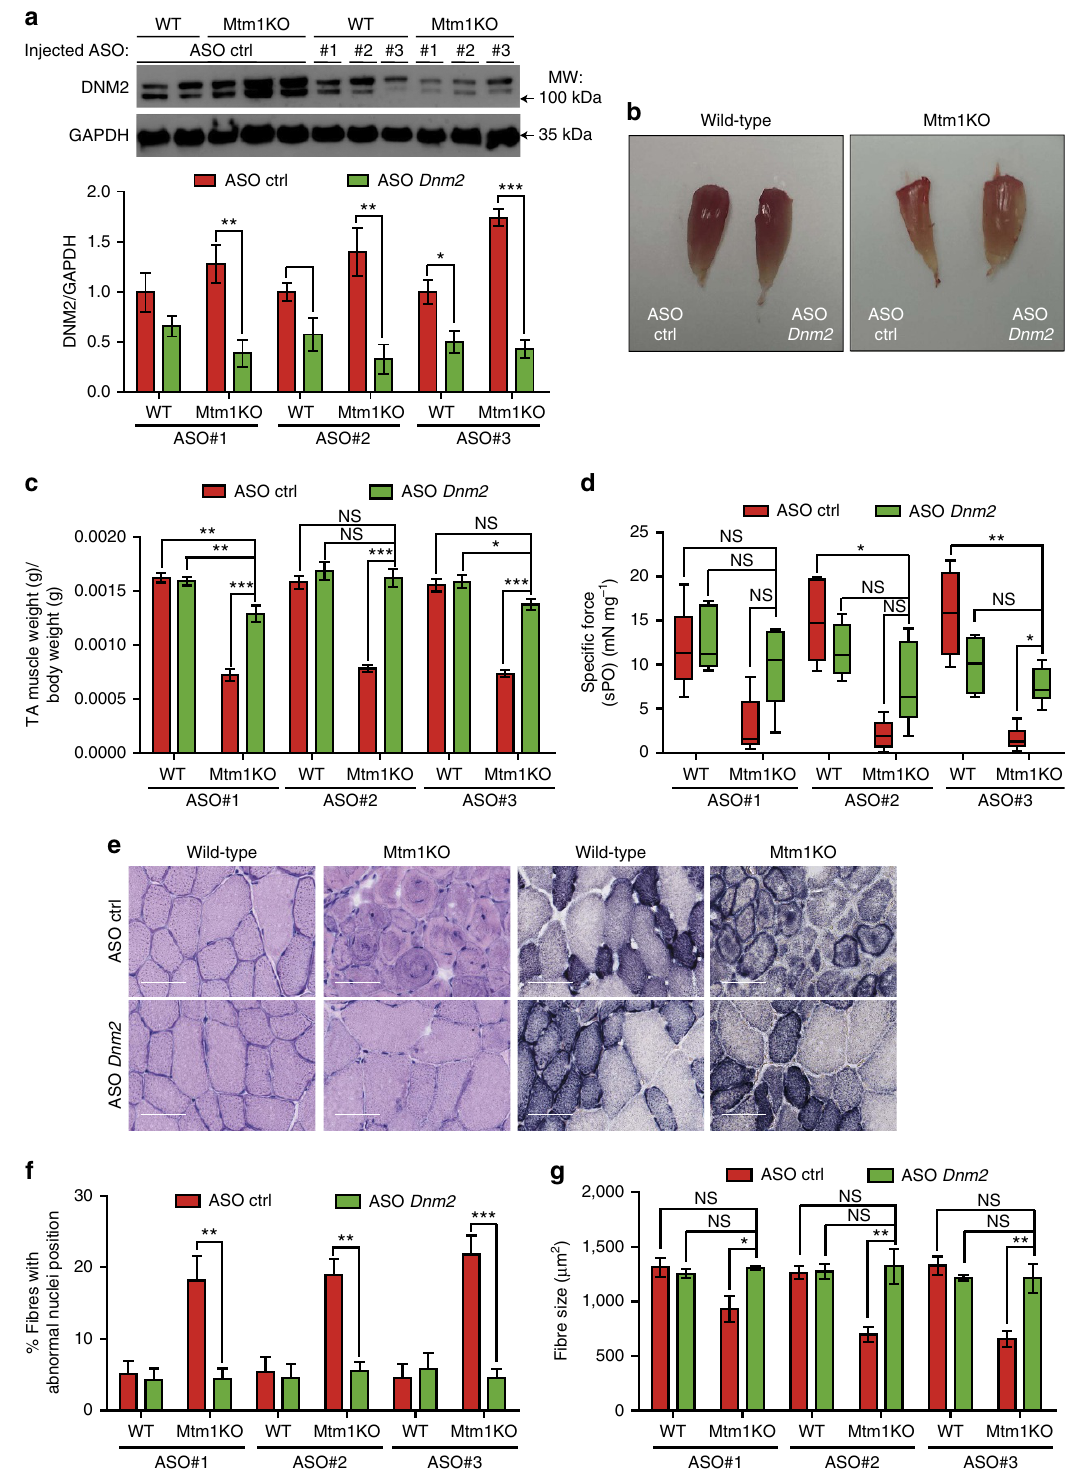
Figure 2 | In vivo validation of ASOs targeting Dnm2 following intramuscular injection. ( a ) Representative western blot of 7-week-old WTor Mtm1KO TA muscles injected with 20 m g of ASO control (ctrl), #1, #2 or #3. DNM2 is present as two bands in muscle tissue. DNM2 densitometries were quantified below and standardized to the loading control GAPDH ( n ¼ 5–7 mice per group). ( b ) Photography of TA muscles from WTor Mtm1KO mice treated with ASO ctrl or ASO Dnm2 #1. ( c ) TA muscle weight relative to body weight ( n ¼ 8). ( d ) Specific muscle force of the TA ( n ¼ 5–6 mice per group).( e ) TA muscle sections were stained with H&E (left) to visualize nuclei positioning or with SDH (right) for mitochondria oxidative activity distribution. Scale bars, 50 m m. ( f ) Percentage of fibres with mislocalized nuclei ( n ¼ 4–6 mice per group). ( g ) Fibre area was determined in 600–1,000 fibres per sample ( n ¼ 5 mice per group). Data represent means ± s.e.m. NS, not statistically significant. * P o 0.05, ** P o 0.01, *** P o 0.001 for TA treated with ASO Dnm2 versus TA treated with ASO ctrl (ANOVA test). kDa, kilodalton; MW, molecular